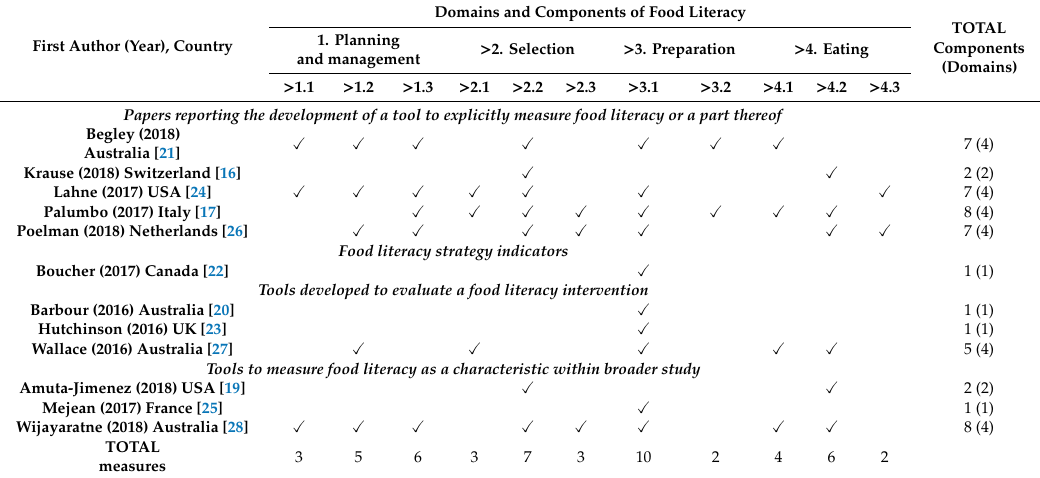
Table 2. The alignment of questions within each reviewed food literacy measurement tool against the four domains and 11 components of food literacy as conceptualised by Vidgen and Gallegos (2014) (refer to Supplementary Material Table S1 for coding of specific